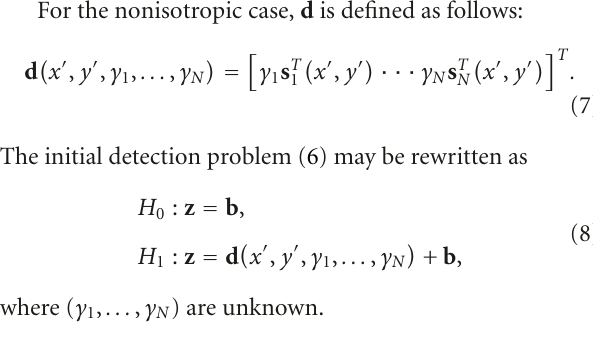
where the definitions of z n ( kT s ), b n ( kT s ), and s n are the are